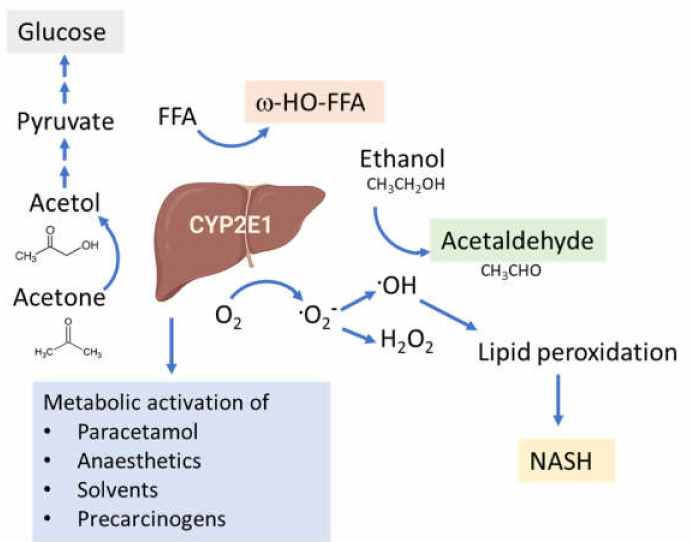
Figure 4. Functions of the CYP2E1 enzyme. CYP2E1 has a role in normal physiological homeostasis by metabolizing endogenous and exogenous compounds. Major endogenous functions are ω - hydroxylation of FFA and oxidation of acetone to precursors of gluconeogenesis. Increased amounts of CYP2E1 results in increased lipid peroxidation and ROS production and is associated with the progression of NAFLD to